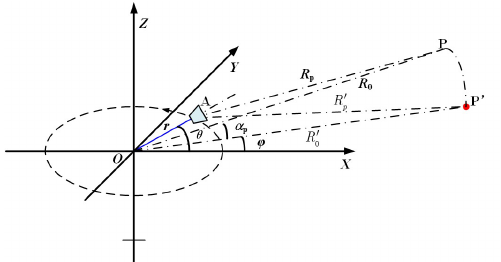
Figure 3. Target with height and its projection on the imaging